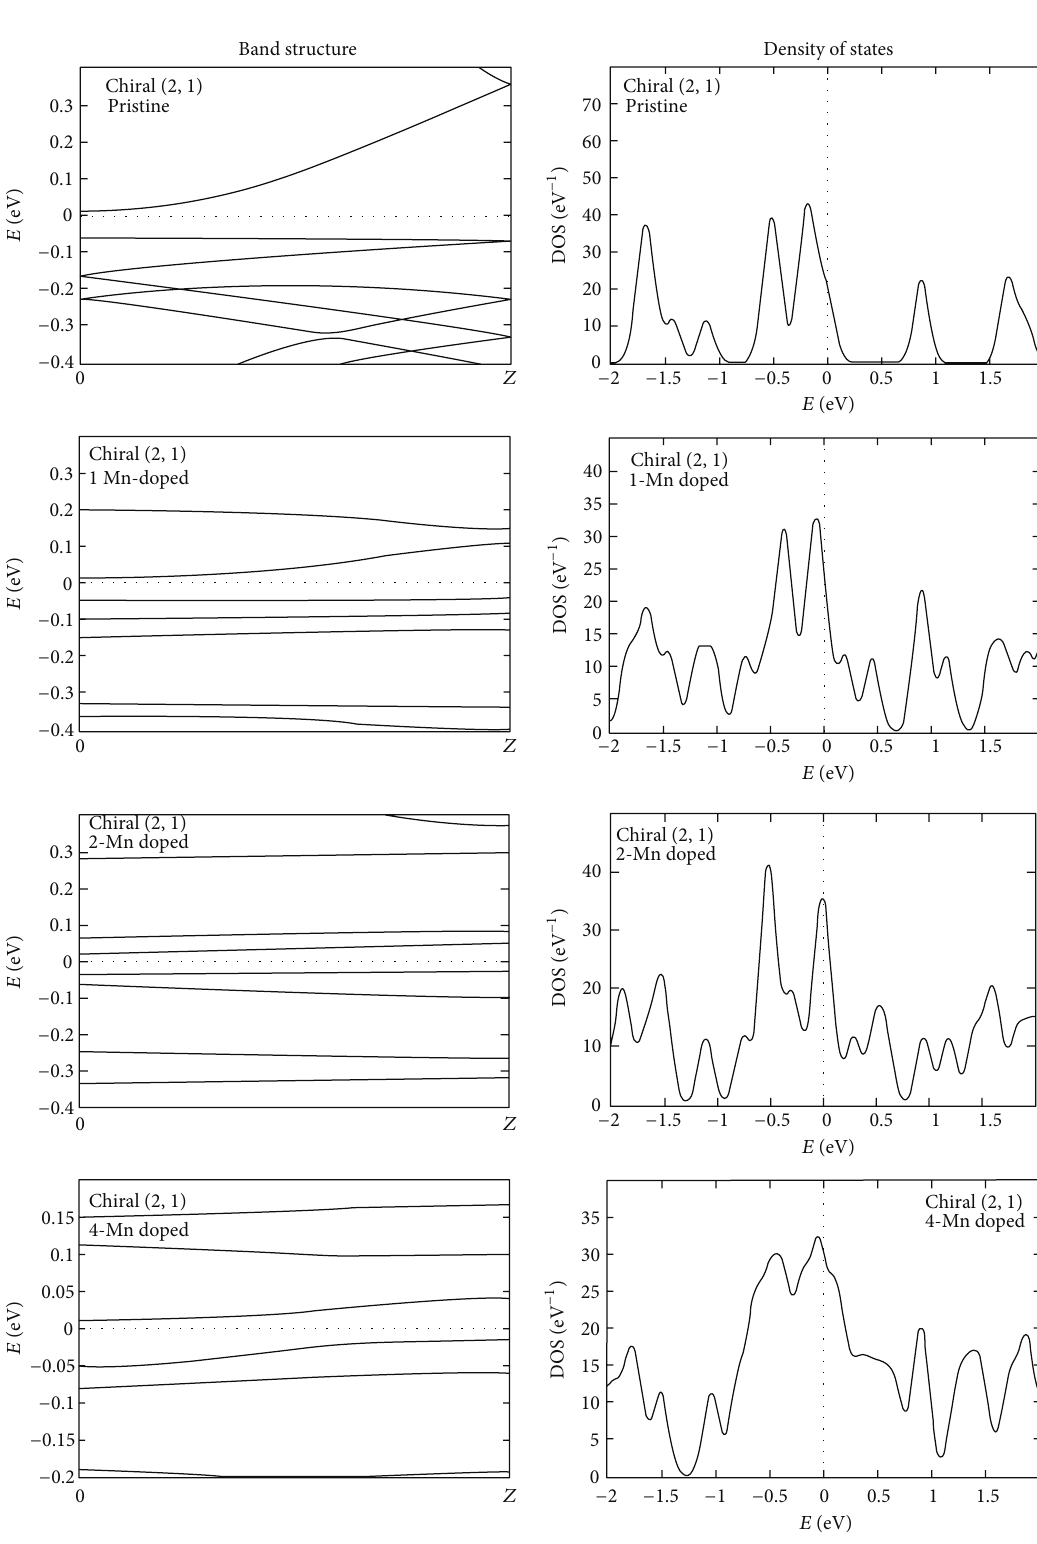
Figure 4: The band structure and density of states of pristine and Mn doped chiral (2, 1) GaN